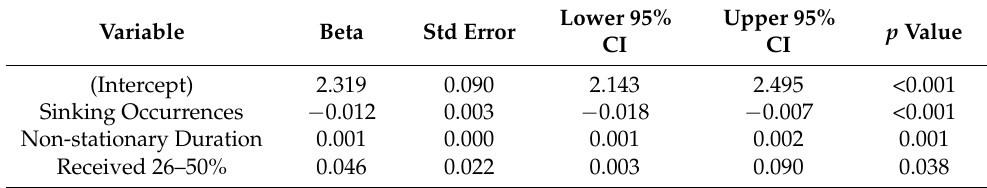
Table 5. Results for the final model examining ODBA.